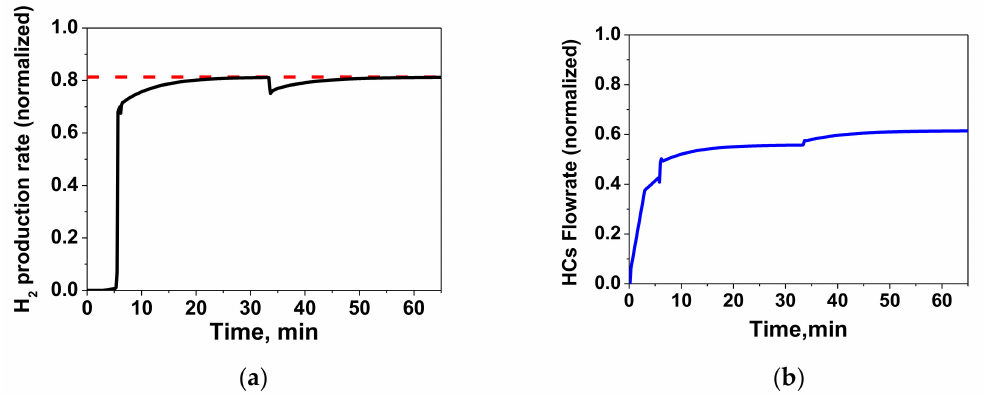
Figure 11. ( a ) H 2 production profile at WGS exit (FC1 controller) and ( b ) HCs flowrate manipulation at the